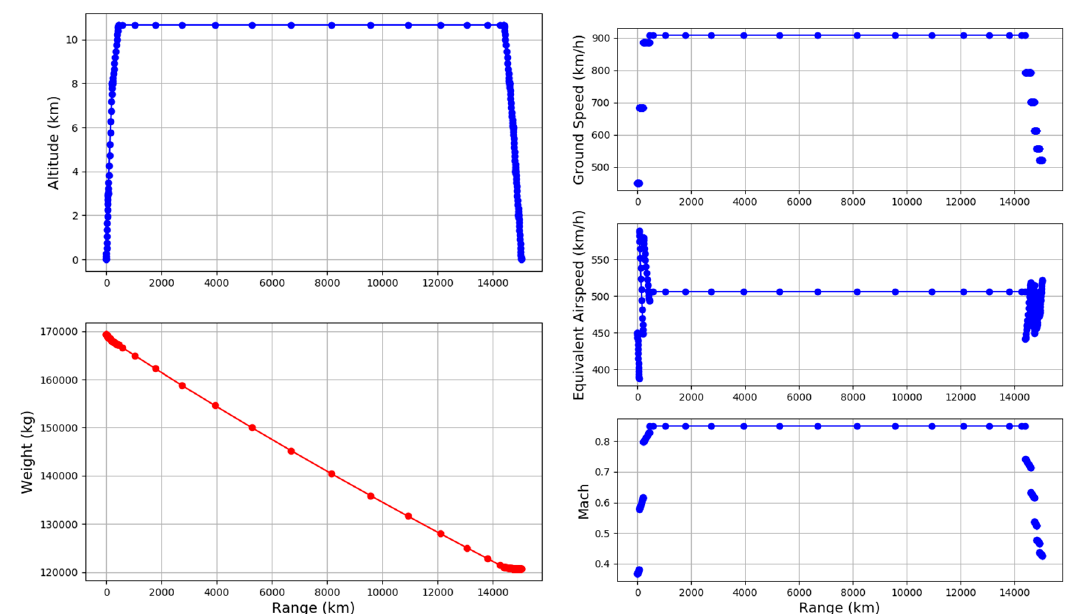
Figure A11. Mission performance of SE²A-LR.